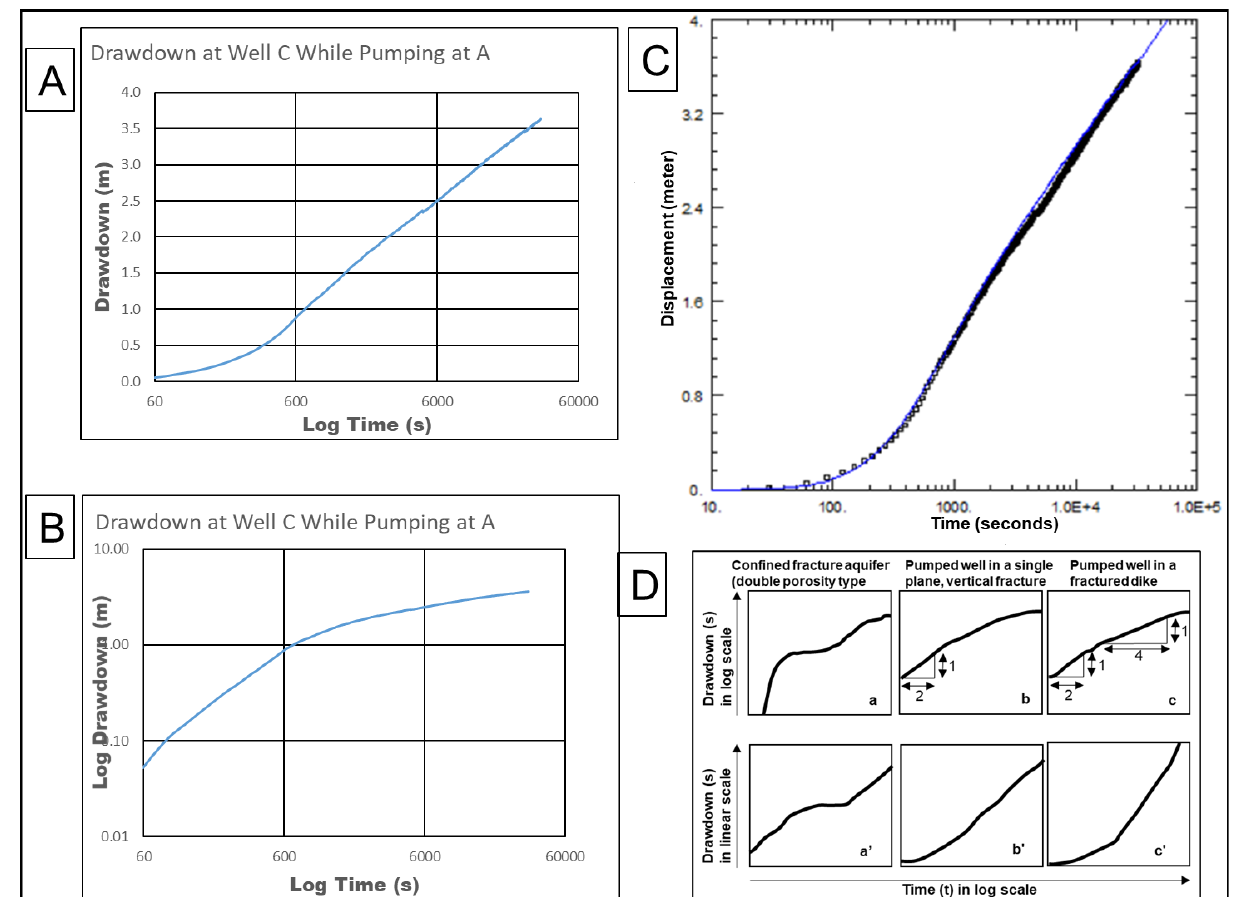
Figure 5. A drawdown versus time plot on a semi-log ( A ) and log – log ( B ) plot for observation at well C while pumping at well A. A fitted drawdown – time curve of the pumping test using the Baker solution for fractured aquifer [88,89] ( C ) with type curves [90] for interpretation of the results are ( D ).